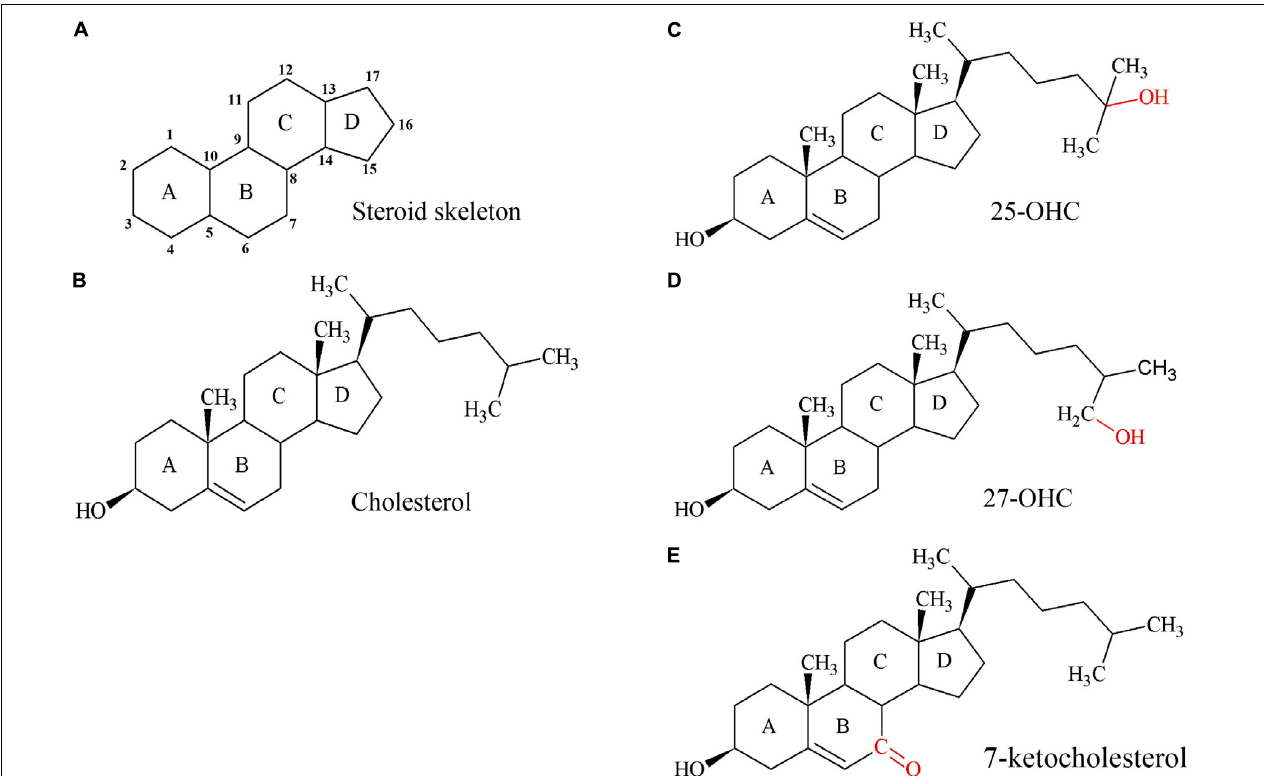
FIGURE 2 | Structures of the steroid skeleton, cholesterol, and common oxysterols. (A) All steroids have the same basic perhydro-1,2-cyclopentenophenanthrene skeleton. Letters designate each ring, the carbon atoms are numbered. A slight variation in this skeleton or the introduction of functional groups result in various classes of steroids. (B) Unesterified cholesterol contains this skeleton with a hydroxyl group, two methyl groups, and a hydrogen tail. In the esterified form, a fatty acid would be bound to the hydroxyl group by an ester bond. (C) 25-hydroxycholesterol (25-OHC), the most extensively studied oxysterol. (D) Oxysterol 27-hydroxycholesterol (27-OHC). (E) Oxysterol 7-ketocholesterol. Red molecules indicate the positions of hydroxylation (C,D) or oxidation (E) of cholesterol to 25- or 27-OHC, or 7-ketocholesterol, respectively. Oxysterols are intermediates of cholesterol catabolism and act as signaling molecules with regulatory impact on various cellular processes including lipid